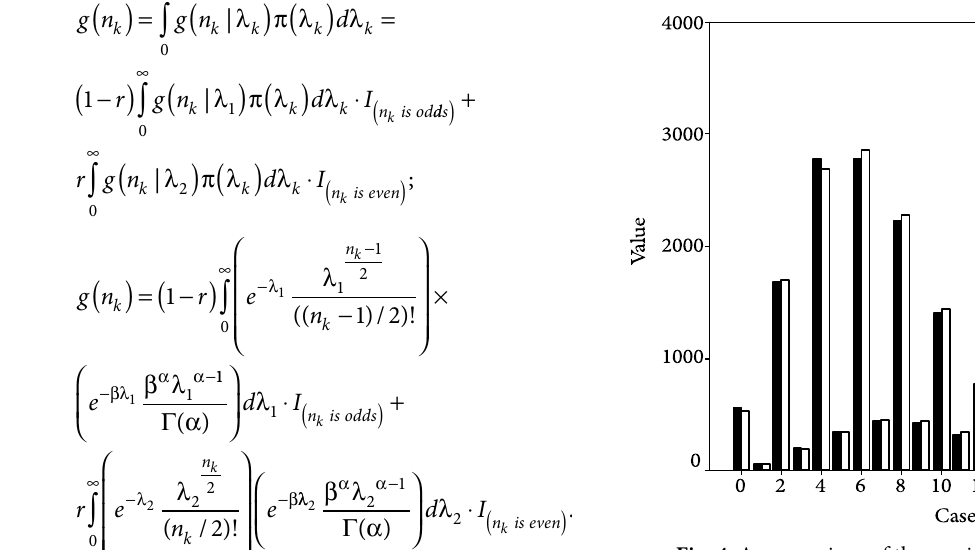
Fig. 4. A comparison of the empirical distribution of household trip numbers with frequency distribution gained through composed likelihood